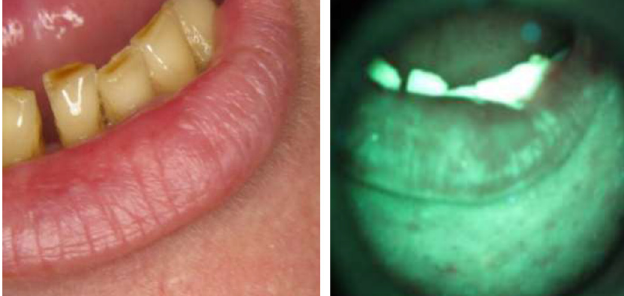
Fig. 1. Lesion of moderate dysplasia observed by the junior with AF. Note that the lesion was not detected under IL. The loss of fl uorescence was located where the patient placed his cigarette